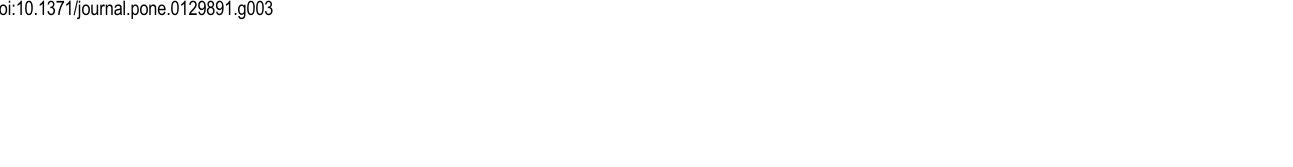
PLOS ONE | DOI:10.1371/journal.pone.0129891 June 10,